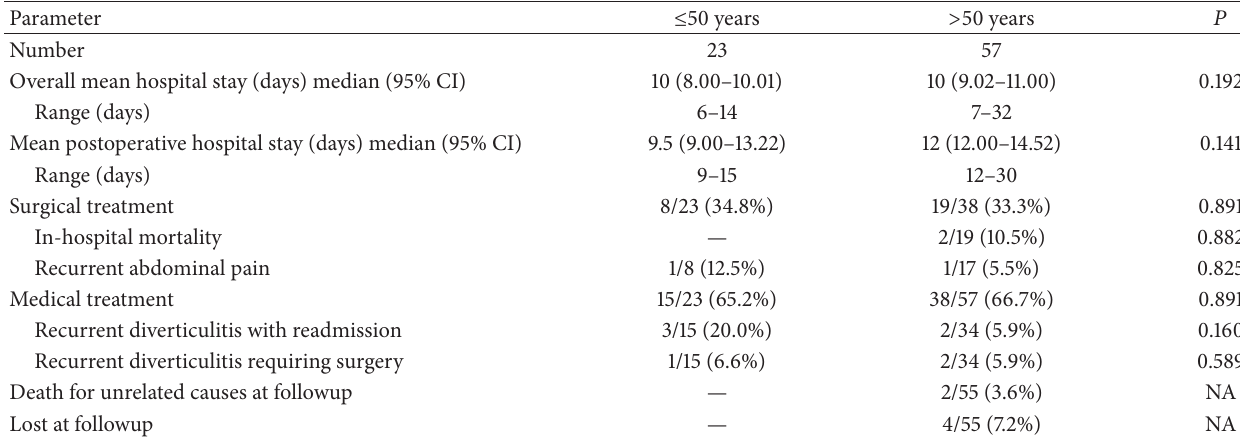
Table 5: Hospital stay, postoperative, and followup results.